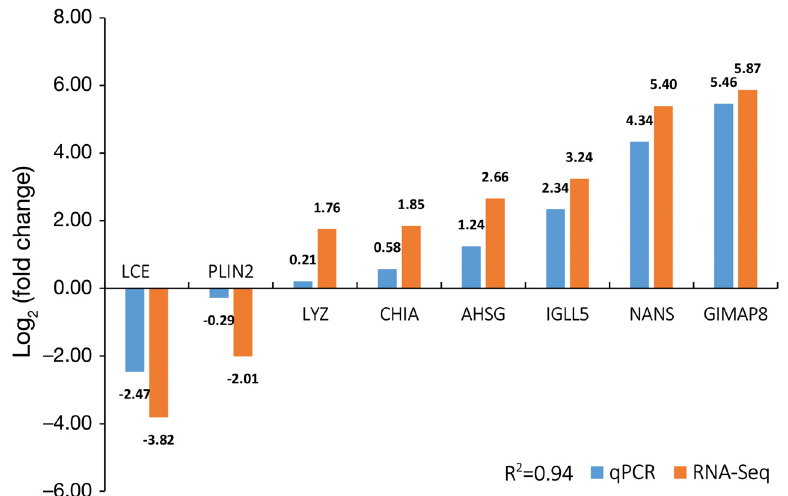
Fig. 6. Validation of yellow drum RNA-seq data by qPCR. Comparison of the rel- ative log 2 (fold change) values of 8 genes between RNA-seq and qPCR